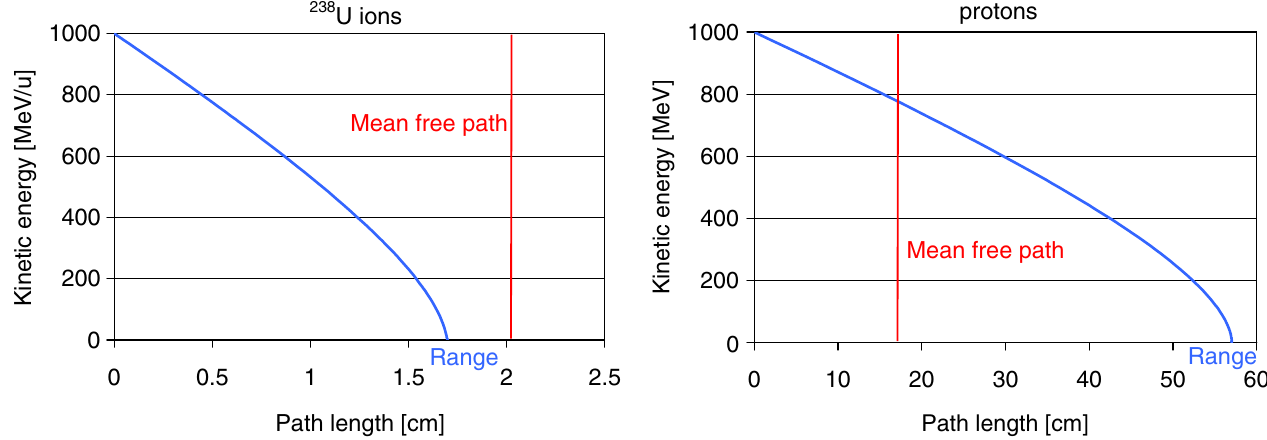
FIG. 6. (Color) Comparison of the Coulomb stopping range and the mean-free path for nuclear interaction of 1 GeV = u 238 U ions and protons in stainless steel. The range was calculated by the SRIM code [36]. The mean-free path was calculated as explained below.